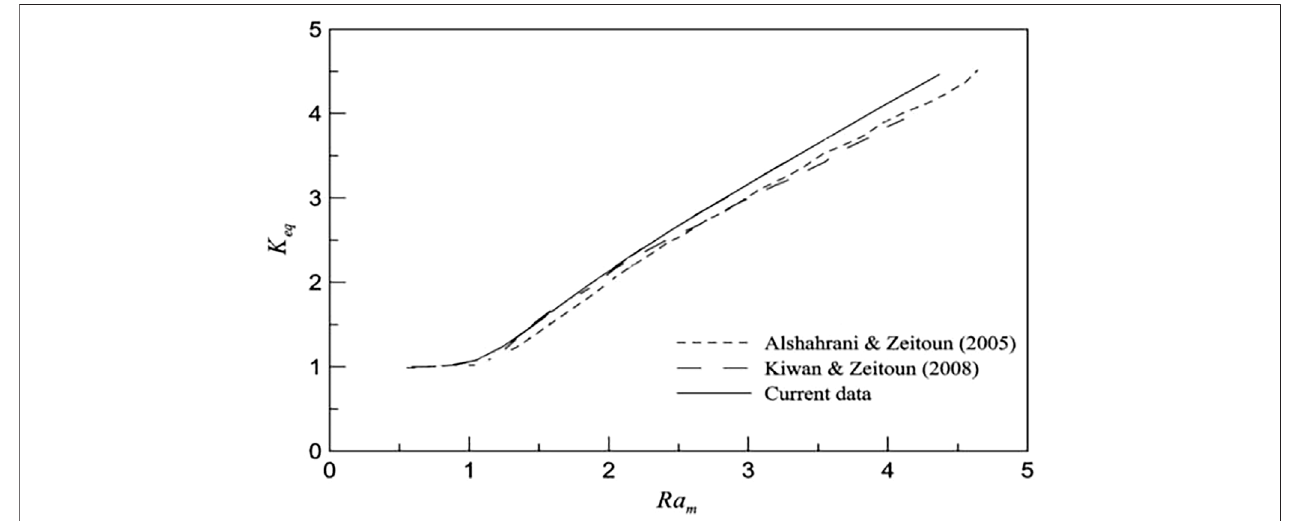
FIGURE 2 | Comparison of current and previous results of the average dimensionless equivalent thermal conductivity of whole cylinder ( K eq ).